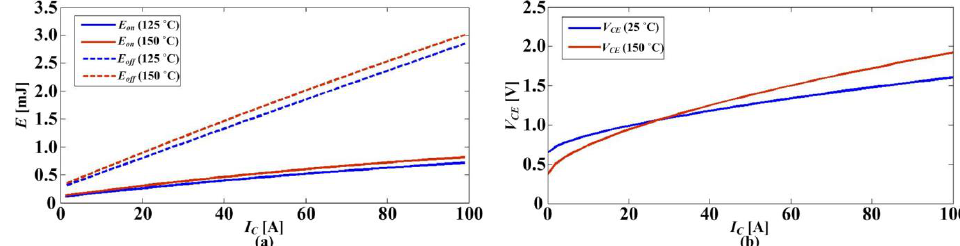
Figure 3. The turn-on and turn-off energies ( E on and E off ) and forward voltage drop ( V CE ) of the IGBT